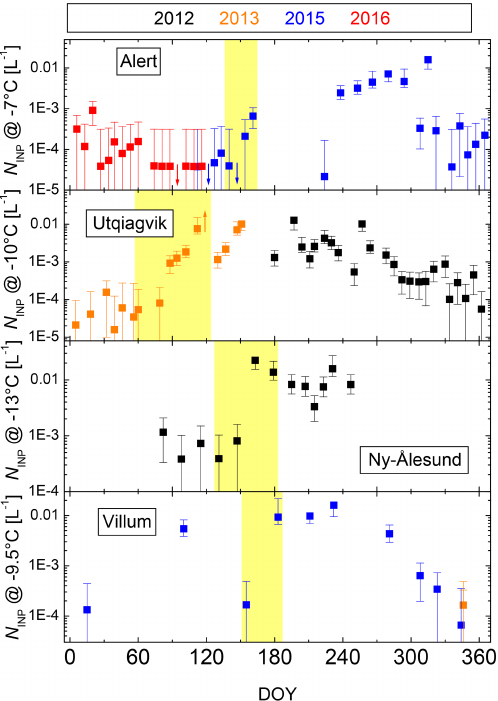
Figure 3. Time series of N INP at T of − 7, − 10, − 13, and − 9 . 5 ◦ C for Alert, Utqia˙gvik, Ny-Ålesund, and VRS, respectively. Small ar- rows in the panels indicate times when values were either below (for Alert) or above (for Utqia˙gvik) the detection limit. The yellow background shows for which samples a more in-depth analysis is presented in Sect. 3.2.2. Error bars show the 95% confidence inter-